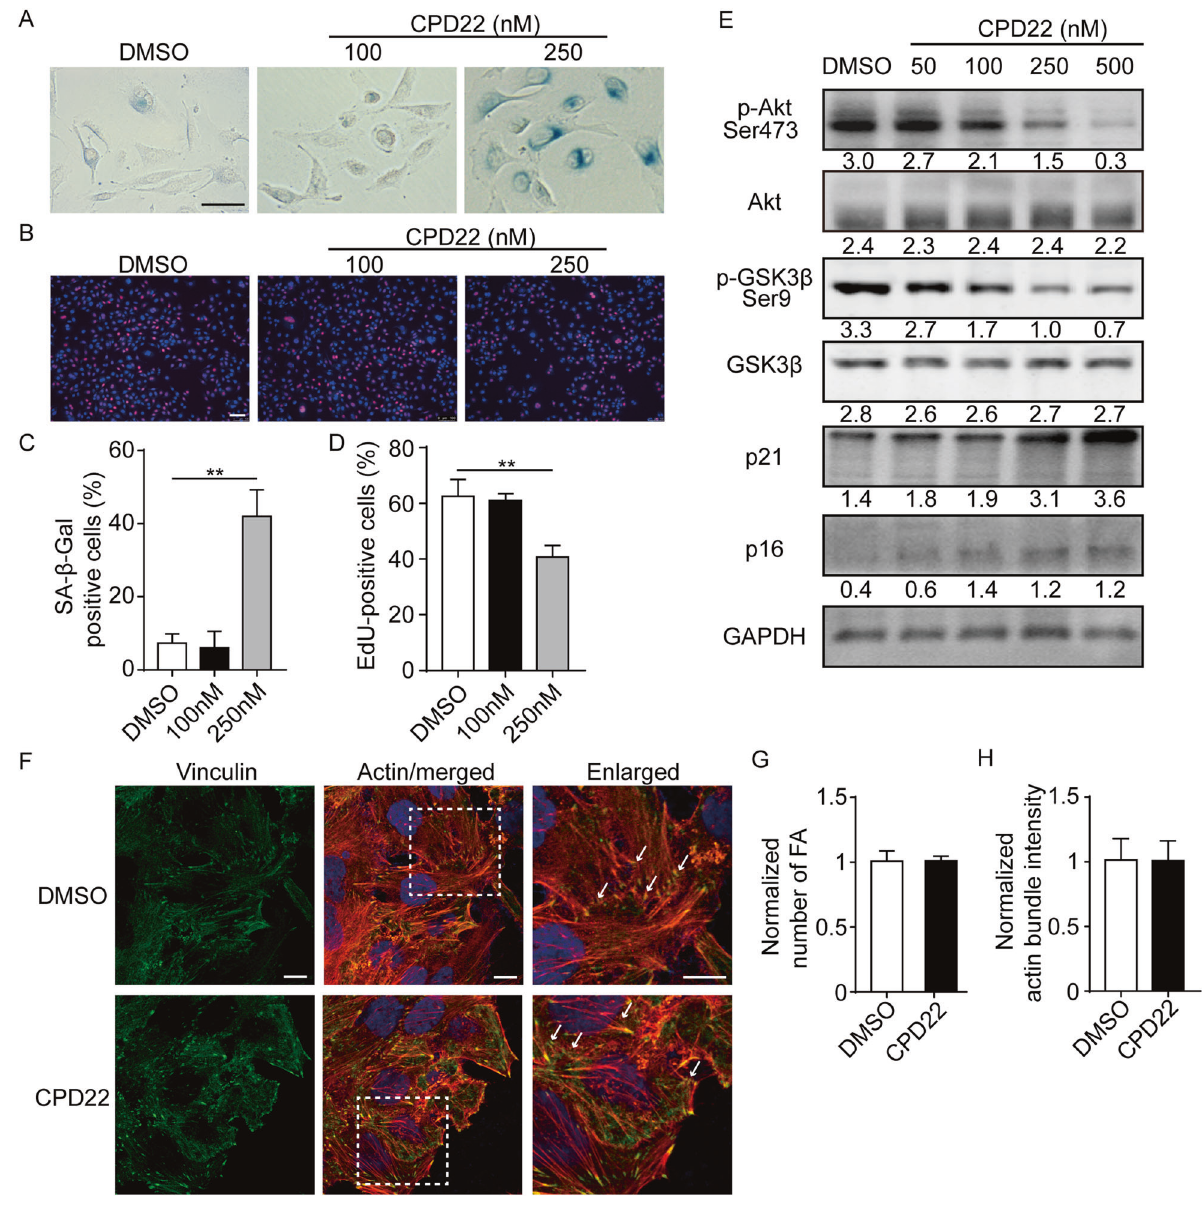
Fig. 8 ILK-mediated cellular senescence was associated with its kinase function in MKN1. A Representative images of SA- β -Gal staining were shown with various concentrations of the ILK kinase inhibitor, Cpd22 for 5 days. Scale bar, 50 μ m. Quanti fi cation of positive cells for the SA- β -Gal assay in A was displayed in B . C Representative images of EdU assay were shown as the dosage of Cpd22 treatment indicated. Scale bar, 100 μ m. Quanti fi cation of EdU positive staining in C was displayed in D . E MKN1 was treated with Cpd22 as indicated for 5 days. Cell lysates were then harvested and immunoblotted for p-Akt (Ser473), p-GSK3 β (Ser9), p21 and p16, with GAPDH as the loading control. F Representative images of FAs (Vinculin stained) and actin bundles (red) in MKN1 cells incubated with DMSO vehicle or 250 nM Cpd22 for 5 days. Arrows, vinculin-positive zone. Scale bar, 10 μ m. Quanti fi cation of number of G FAs and H intensity of actin bundles. n ≥ 50 cells per group from three independent experiments. Data represent the mean ± SD of at least three independent experiments. ** p < 0.01. (Fig. 7A – C, Supplementary Fig. 7A, B). These results indicated that the catalytic domain of ILK mediates cellular senescence in MKN1 cells. Consistently, overexpression of ILK lacking the N- terminus- ANK repeats or the full-length ILK in senescent ILK KO cells were both capable of restraining not only β -Gal activity induced by ILK KO but also the elevation of p21 and p16 expression (Fig. 7D – F, Supplementary Fig. 7C – E). Interestingly, despite no alteration in proliferation, overexpression of ILK E359K mutant partially reversed the number of β -Gal positive cells and expression of p16 in the senescent MKN1 and MKN28 cells.